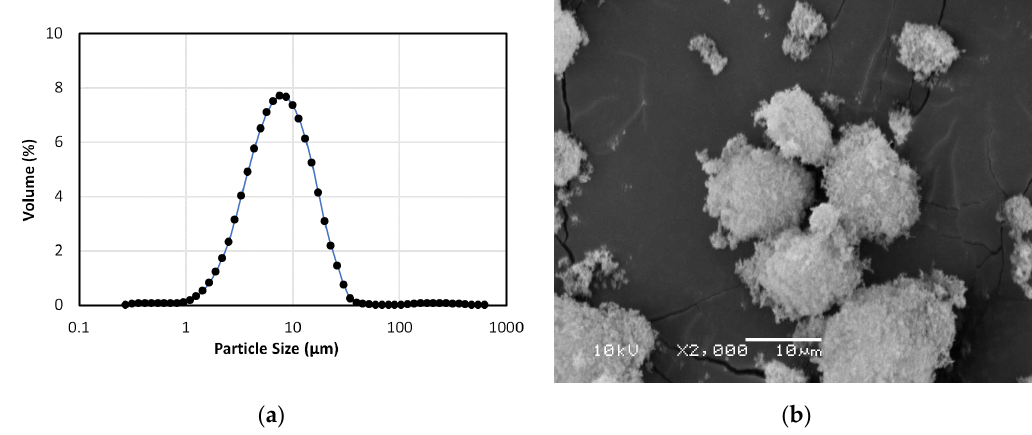
Figure 2. Size characterization of the sieved sample of hydrophobic nanopowder; ( a ) Particle size distribution; ( b ) Agglomerate morphology in SEM micrographs.